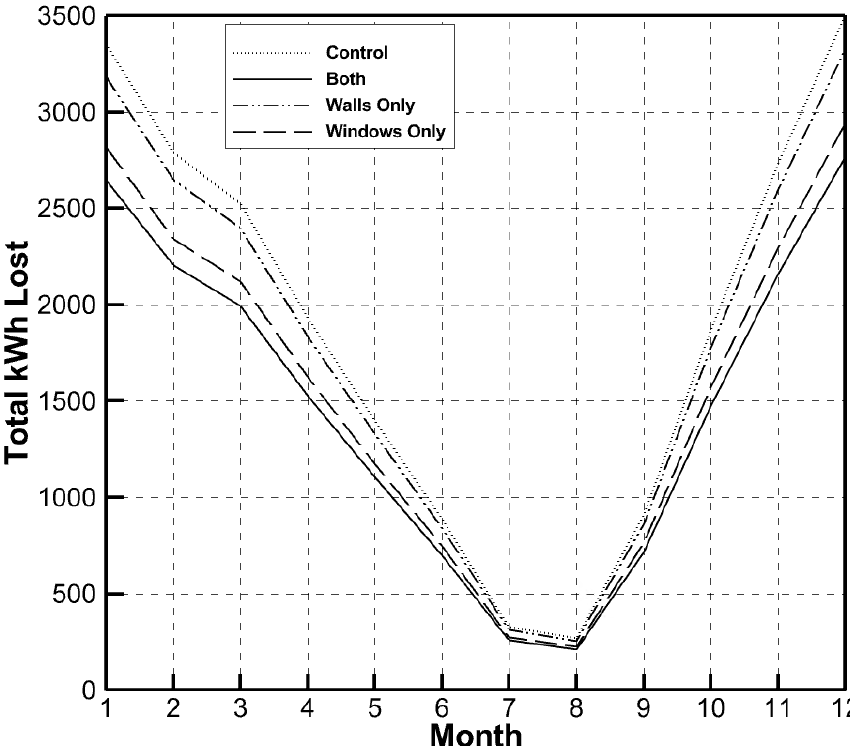
Figure 4. Total kWh loss per month for each simulation scenario.